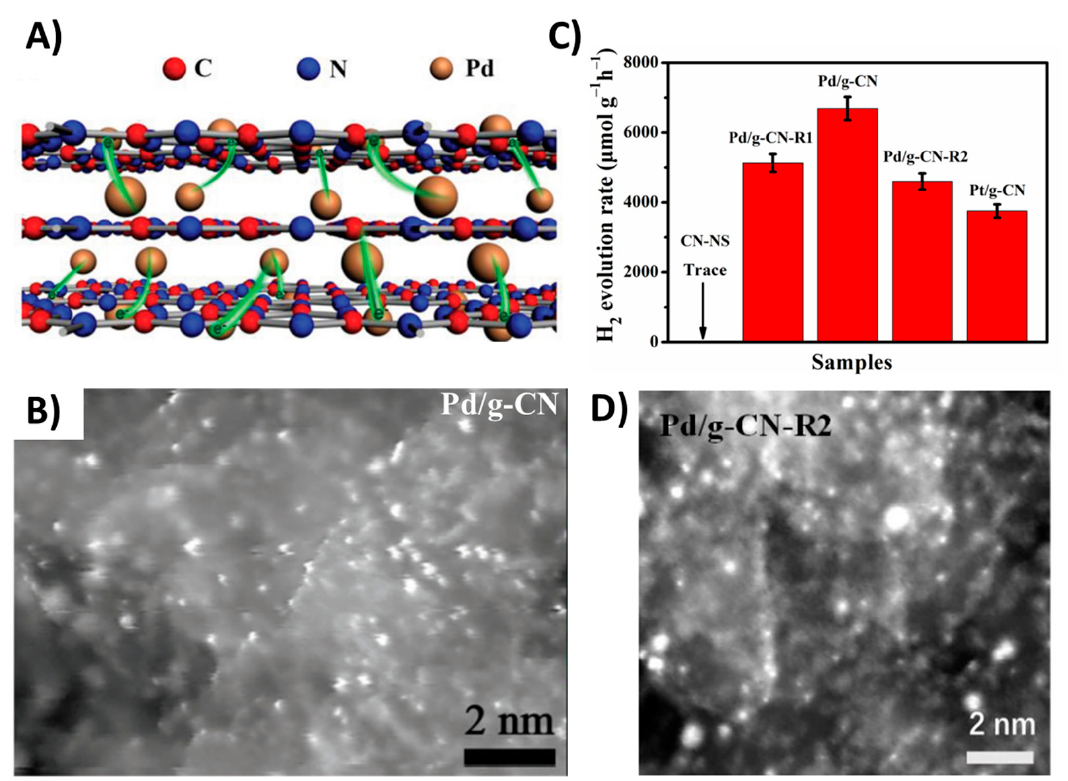
Figure 20. ( A ) Schematic illustration of Pd/g-CN hybrid with the Pd single atom bridges and the surface anchor of Pd atoms; ( B ) Aberration-corrected HAADF-STEM image of Pd/g-CN where with bright dots we can see the Pd single atoms; ( C ) Comparison of photocatalytic H 2 evolution activities of the different Pd-based single atom g-CN catalysts and the pristine CN-NS material; ( D ) HAADF-STEM image of the reference sample Pd/g-CN-R2 where we can see the formation of Pd clusters/nanoparticles. Adapted from [108] with permission.